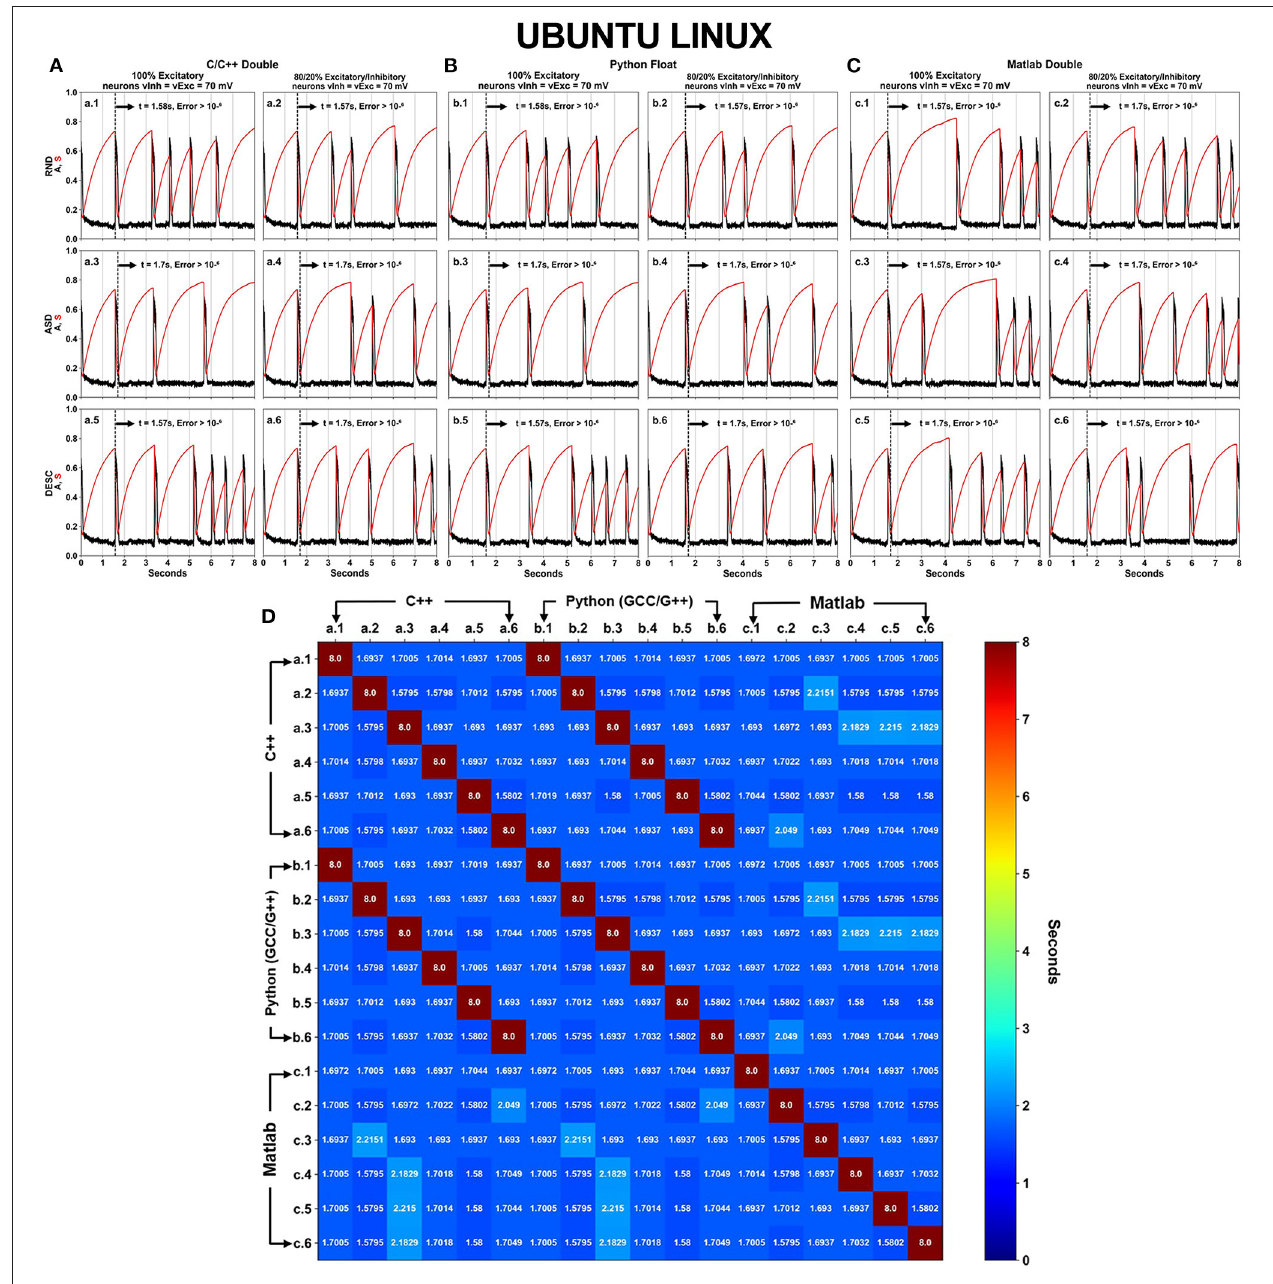
FIGURE 5 | Neural activity results simulated using DFPP on Ubuntu Linux which did not replicate the HFPP results. Like in Figure 4 , Panels (A–C) show the spontaneous network activity < A > (black curve) and the network synaptic efficacy < S > (red curve) for languages/software programs. The black vertical dashed line in each graph shows the time when the absolute error is > 10 − 6 in comparison with the simulation that used HFPP ( Figure 3 ). When the comparison was done among these 18 scenarios, replicability between C/C ++ (A) and Python GCC/G ++ (B) were observed as shown by dark red cells in (D) .